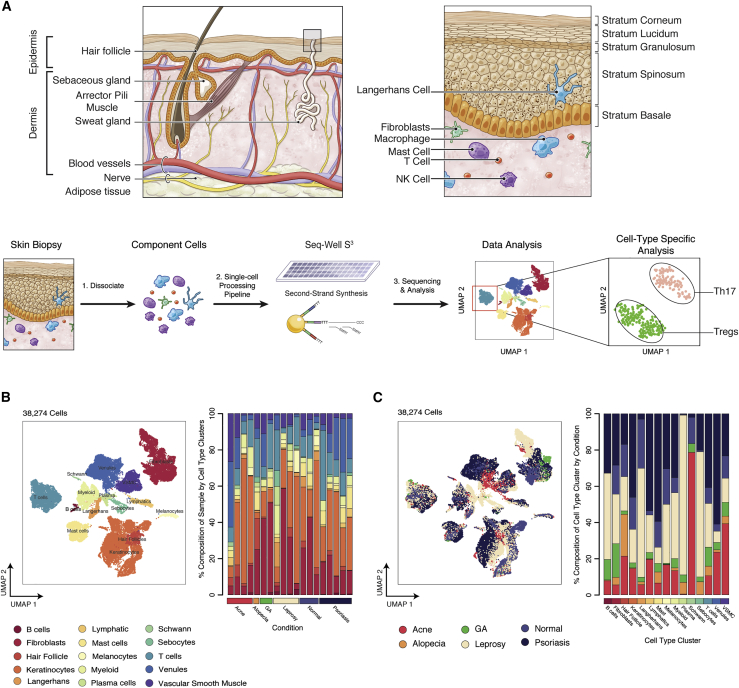
Cell Types Recovered across Inflammatory Skin Conditions(A) (Top, left) Illustration of the anatomic organization and major features of human skin. Shown at the top, right is the cell type composition of the epidermis and dermis. Shown on the bottom is a sample processing pipeline for skin samples (Table S2).(B) (Left) UMAP plot for 38,274 cells colored by cell type cluster. Shown on the right is a stacked barplot depicting the cell type composition for each of the 19 skin biopsies.(C) (Left) UMAP plot for 38,274 cells colored by inflammatory skin condition. Shown on the right is a stacked barplot depicting the proportion of cells from each skin condition within phenotypic clusters.